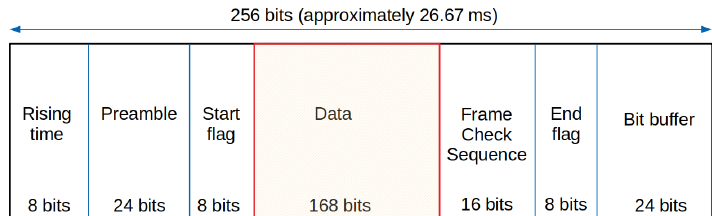
Figure 11. AIS data packet